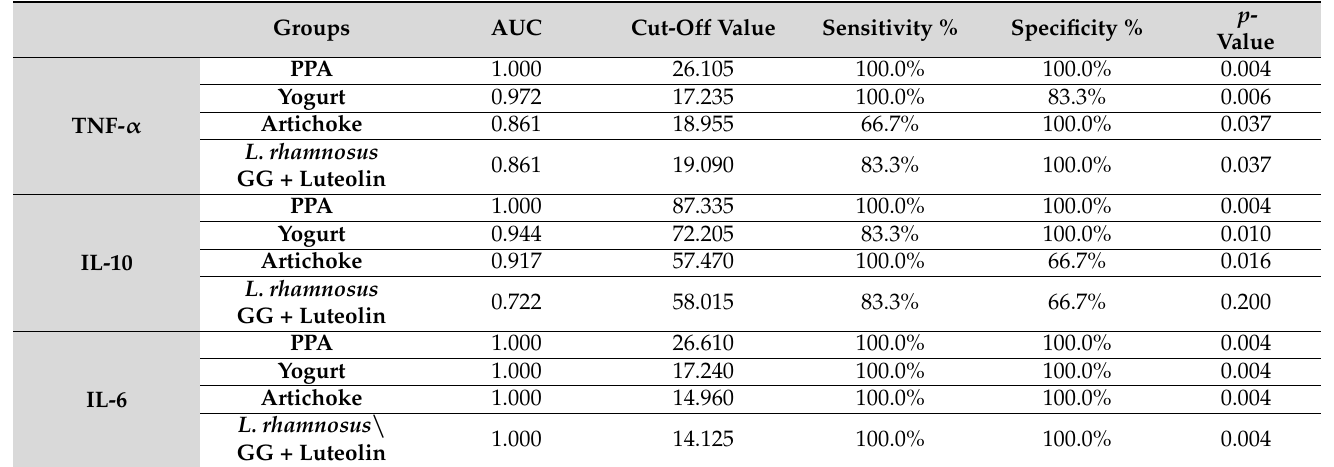
Table 4. ROC results of TNF- α , IL-10, and IL-6 in the tissue homogenates of the PPA-induced rodent model of autism and yogurt, artichoke, and combined L. rhamnosus GG + luteolin nutritionally treated the groups relative to the control